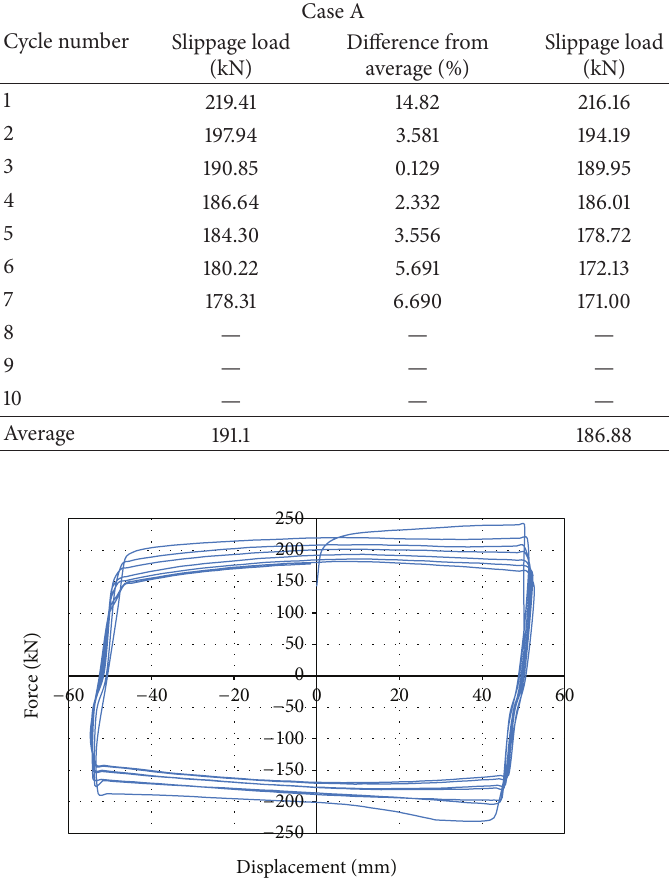
Figure 4: Experimental hysteretic force-displacement curve of the original CFD (case A).